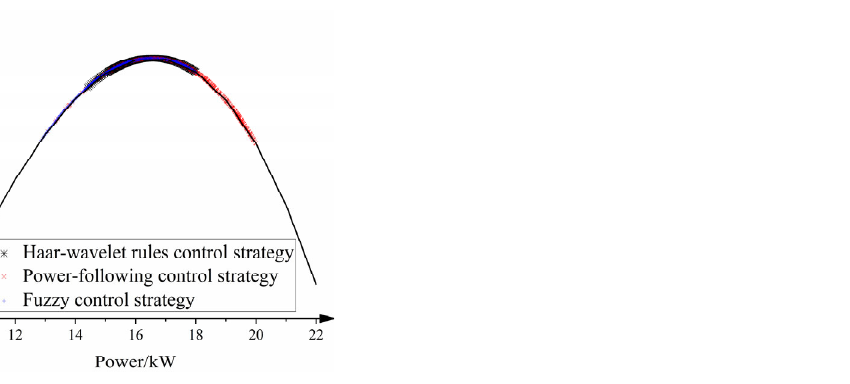
Table 2. Comparison of the efficiency of hydrogen fuel cells with different control strategies.